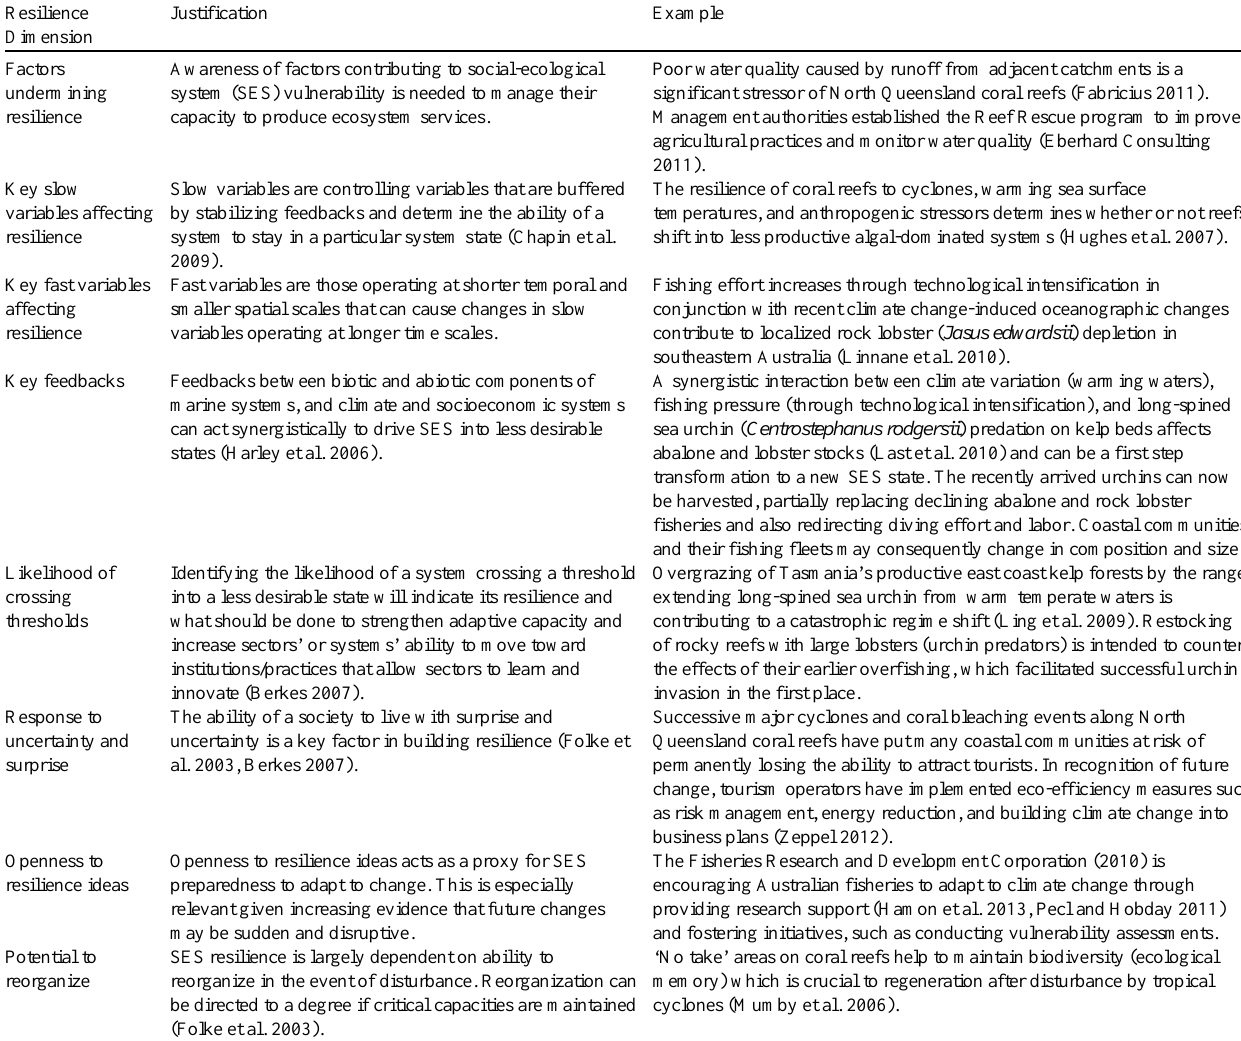
Table 2 . Resilience dimensions, justification, and illustrative